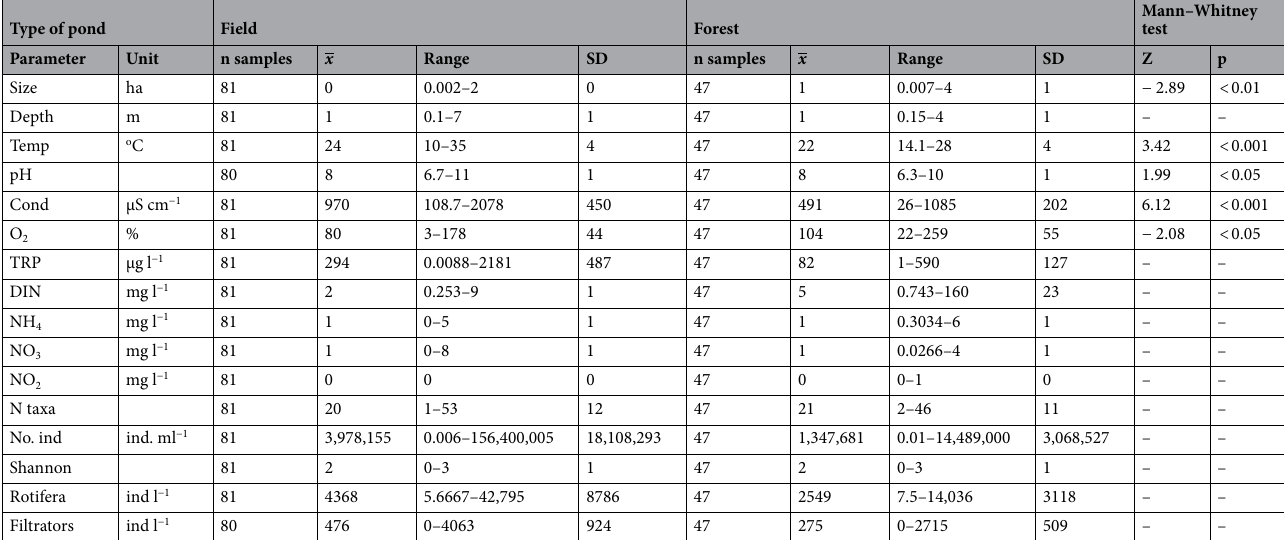
Table 1. Limnological parameters ( Temp water temperature, pH water reactivity, Cond conductivity, O 2 water saturation, TRP total reactive phosphorus, DIN dissolved inorganic nitrogen, NH 4 ammonium, NO 3 nitrates, pond types (field vs. forest). The results of Mann–Whitney test are